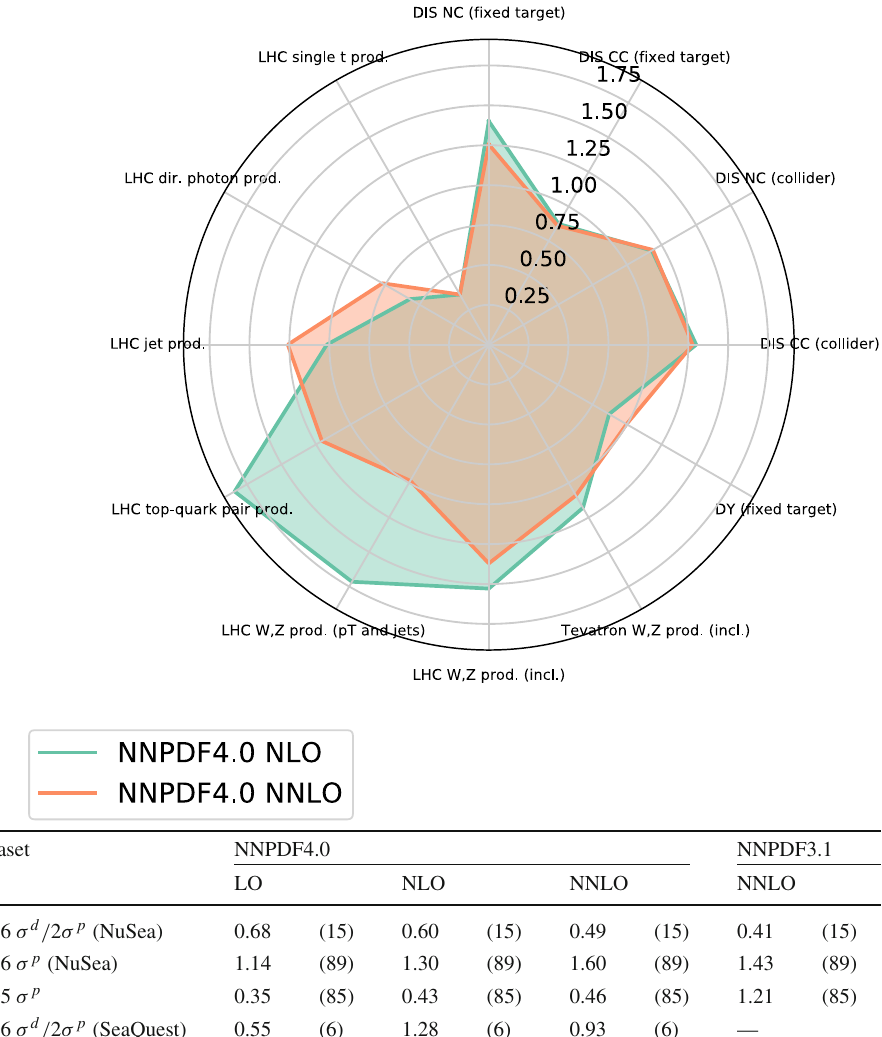
Table 20 Same as Table 19 for fixed-target DY datasets